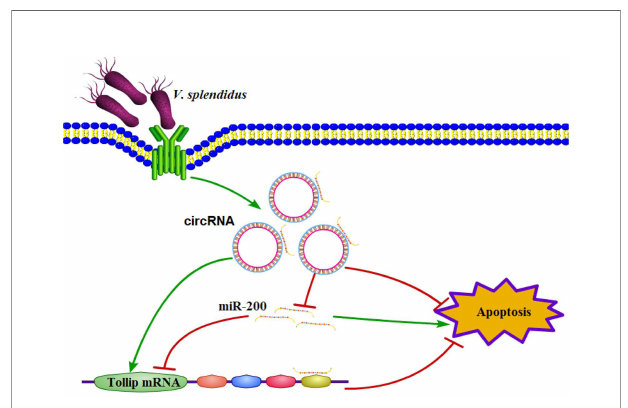
FIGURE 5 | Schematic diagram displaying the mechanism underlying the two circRNAs as endogenous ceRNA